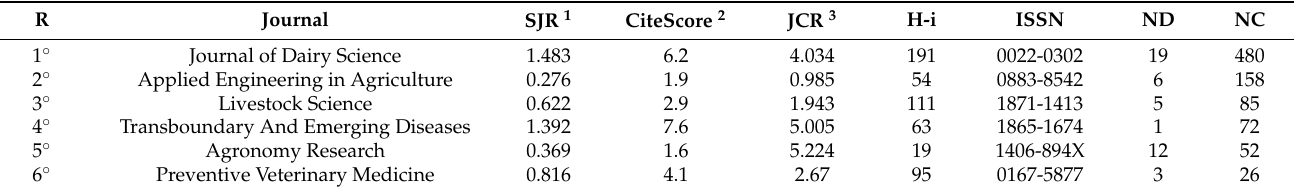
Table 2. Top 6 sources of publications in the world on compost barn from 2007 to